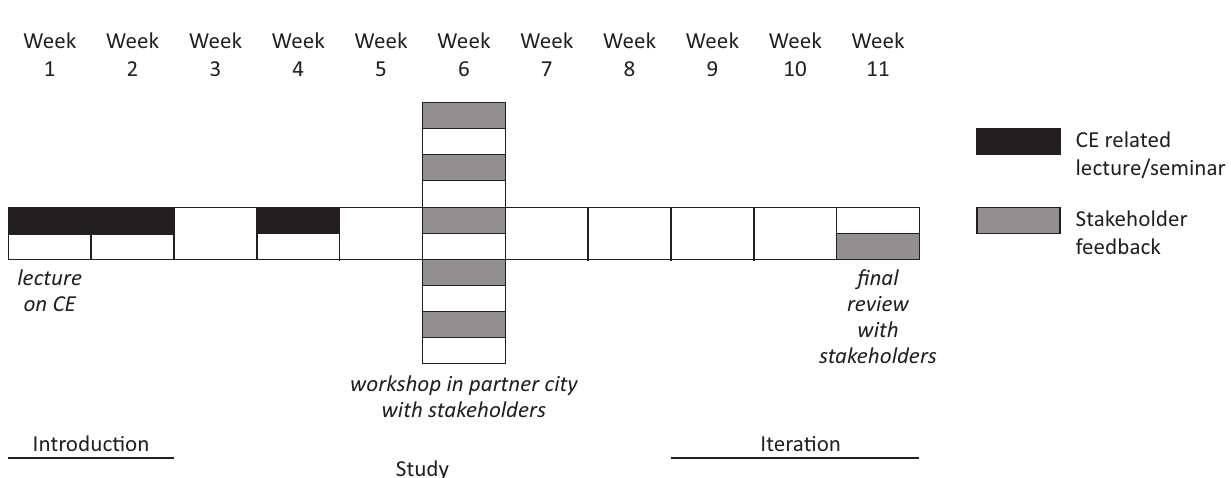
Figure 3. The simplified timeline of the course “Geodesign for a Circular Economy in Urban Regions” illustrating the CE related input and stakeholder